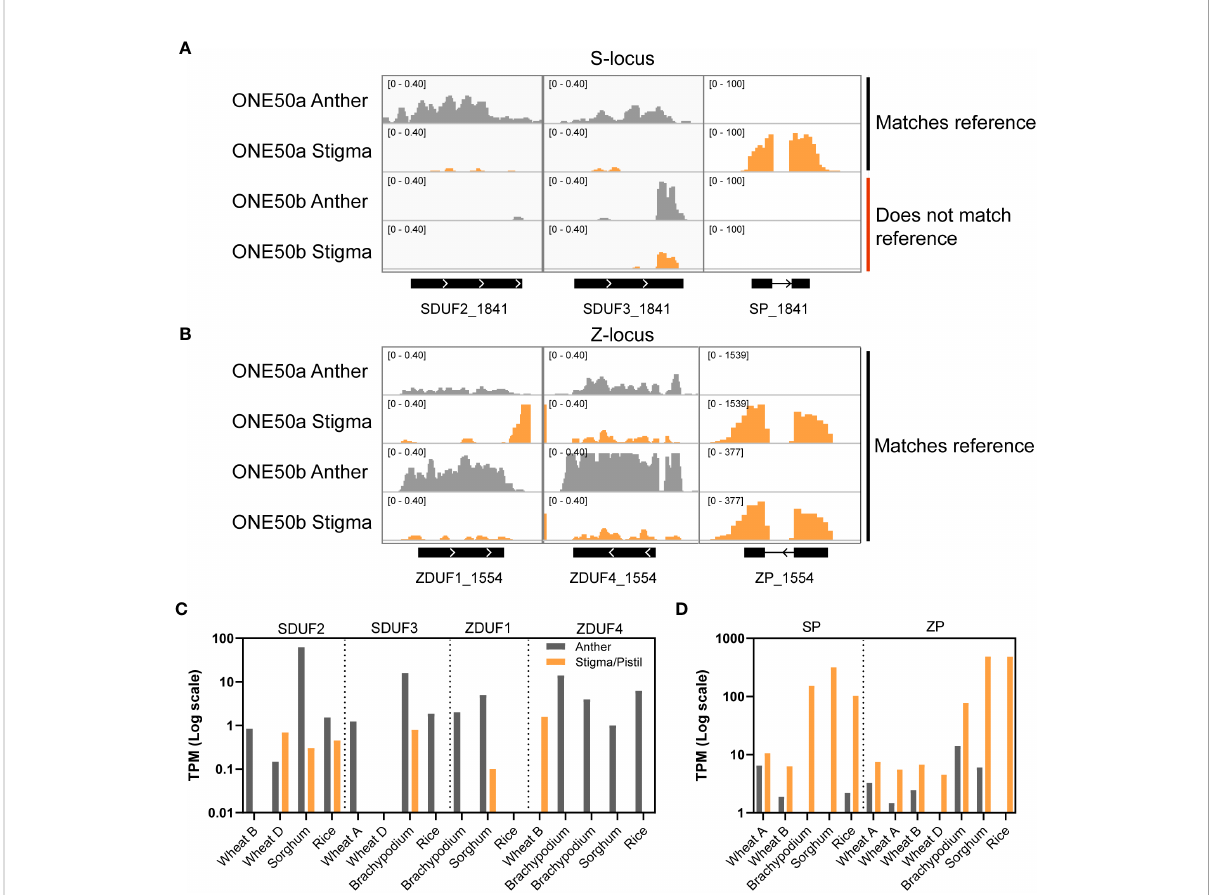
FIGURE 2 Expression of DUF247 and SP/ZP in reproductive tissues from grasses. (A, B) RNAseq coverage at the S- (A) and Z-locus (B) in anther and stigma tissue from two ONE50 individuals. One plant (ONE50a) was a clone of the individual used to create the reference sequence, and had the corresponding genotype at S- and Z-, while the other (ONE50b) only had the corresponding Z-locus genotype. Numbers in the top left of each sub-panel indicate the y-axis scale in units of coverage in reads per million over 25bp windows. (C, D) Expression of DUF247 (C) and SP/ZP (D) genes from rice, wheat, sorghum and brachypodium in anther and stigma (or pistil) from expression